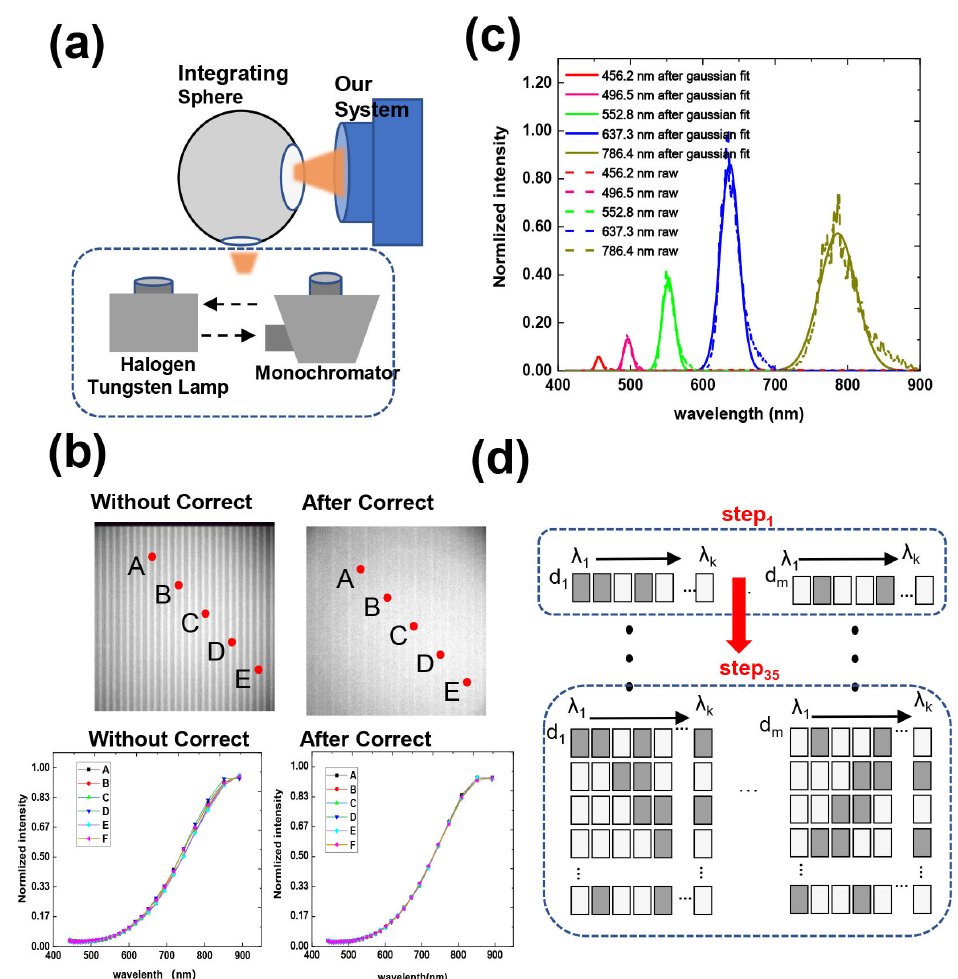
Figure 6. Process and results of system calibration. ( a ) Overview of our methods and design for calibration. ( b ) Comparisons between images and spectrum with and without spectral correction. ( c ) Fitting results of measured spectral response. ( d ) Procedure for acquiring coding matrix.